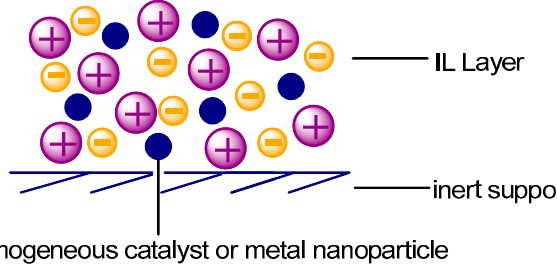
Figure 4. Model of the supported ionic liquid (IL) phase catalysts (SILPC) structure.